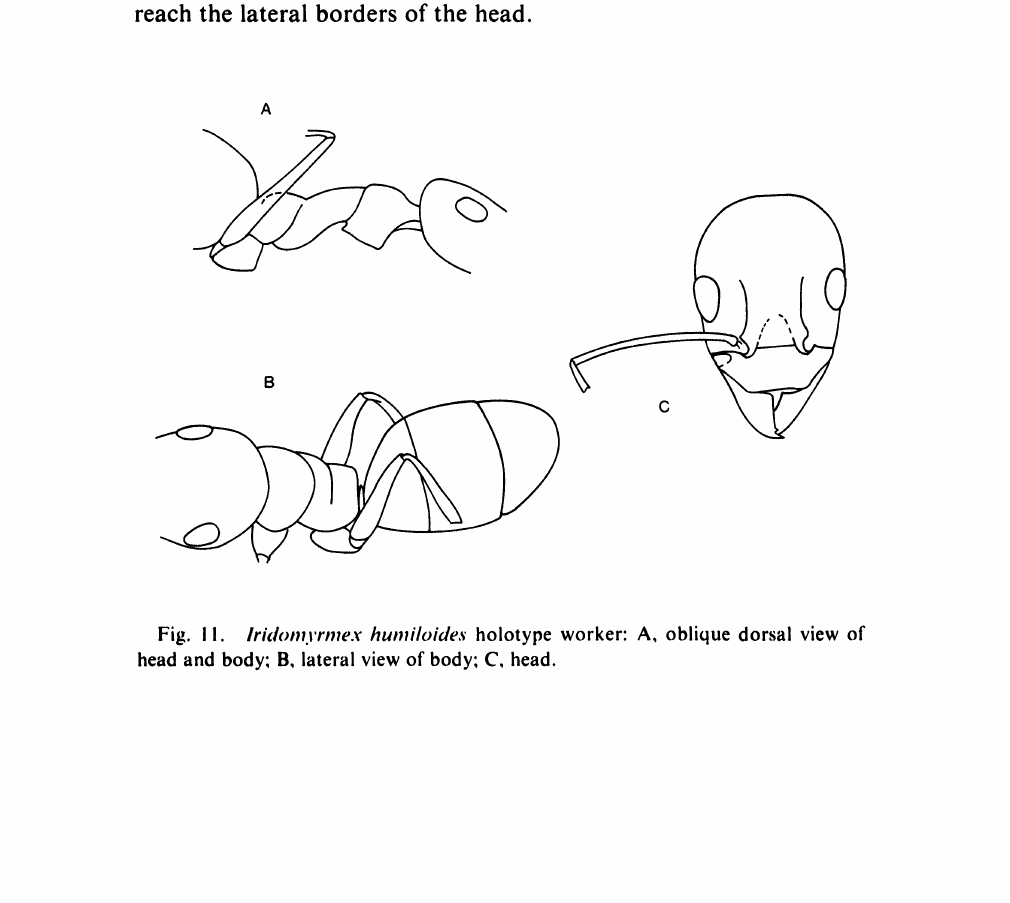
Fig. II. lridomyrmex humiloides holotype worker: A, oblique dorsal view of head and body; B, lateral view of body; C,